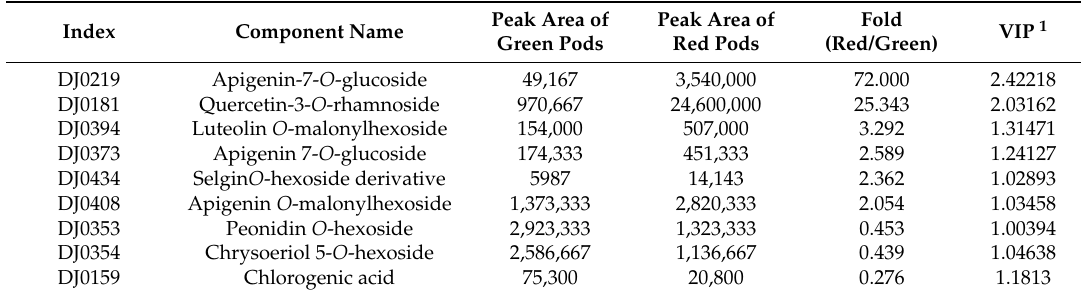
Table 1. Significantly different flavonoids of 30-day-old green and red